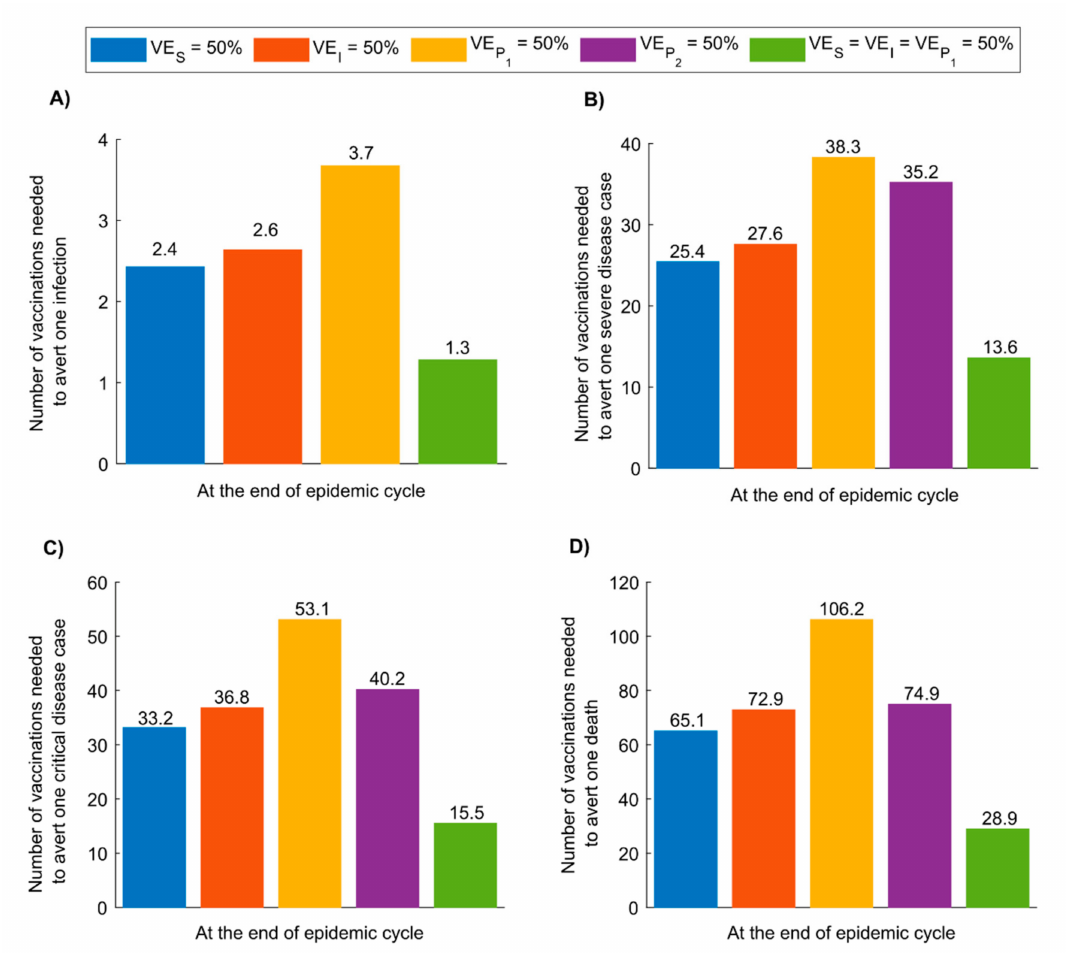
Figure 3. SARS-CoV-2 vaccine e ff ectiveness. Number of vaccinated persons needed to avert ( A ) one infection, ( B ) one severe disease case, ( C ) one critical disease case, and ( D ) one death, by the end of the epidemic cycle, that is, after the epidemic has reached its peak and declined to a negligible level. The scenario assumes vaccine scale-up to 80% coverage before epidemic onset. Duration of vaccine protection is 10 years. Impact was assessed at VE S = 50%, VE I = 50%, VE P = 50%. Panel A does not include the result for VE VE S = VE I = VE P 1